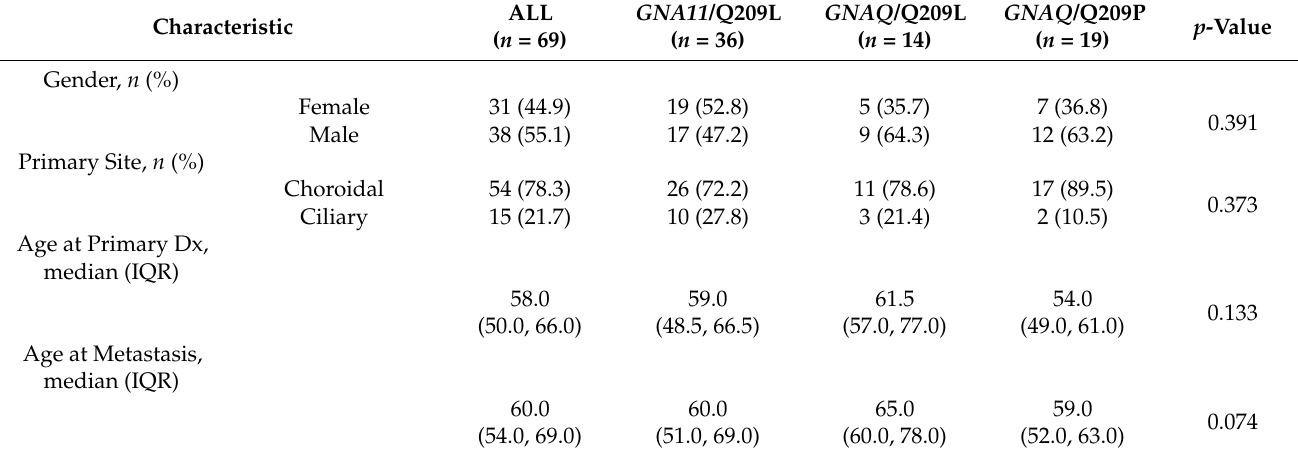
Table 3. Association between Patients Characteristics and the Type of Gene Mutation.